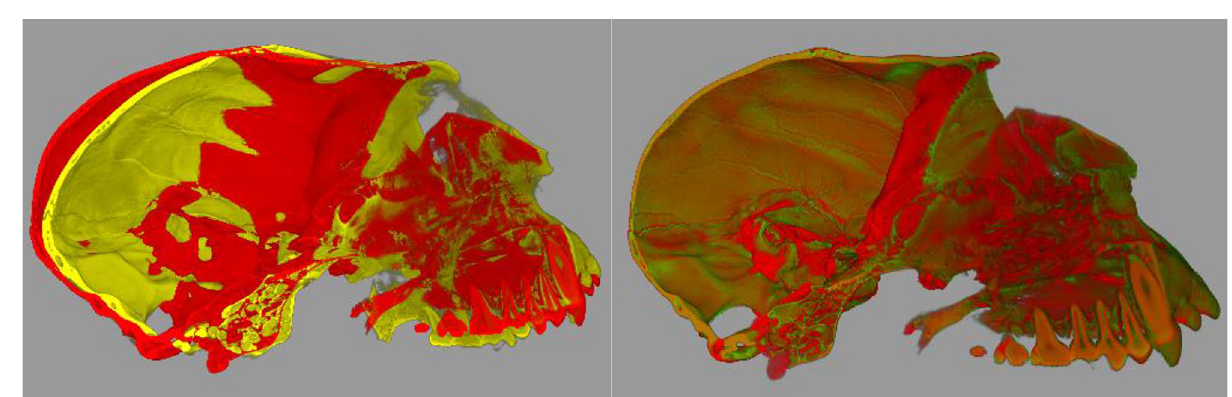
Figure 3. CT scans of two Callicebus cupreus skulls archived in MorphoSource. (Left) original and (right) registered using symplectomorphic non-linear registration. The yellow is registered to the red. Red is the “template”, yellow is warped to the “template”